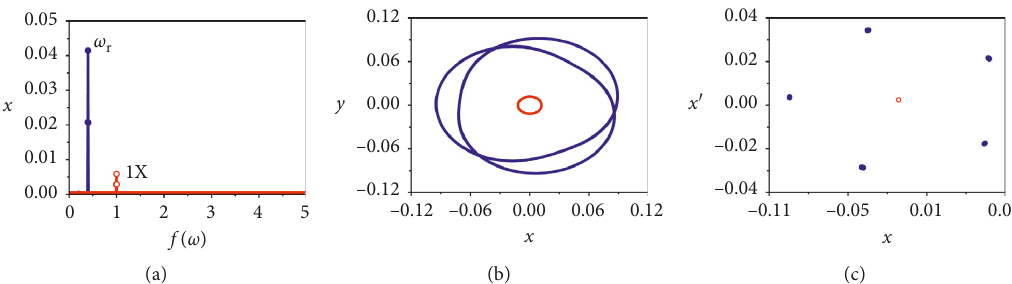
Figure 11: The response of the rotor/seal system with the DVA at s rotor. (c) The Poincar´e map of the x